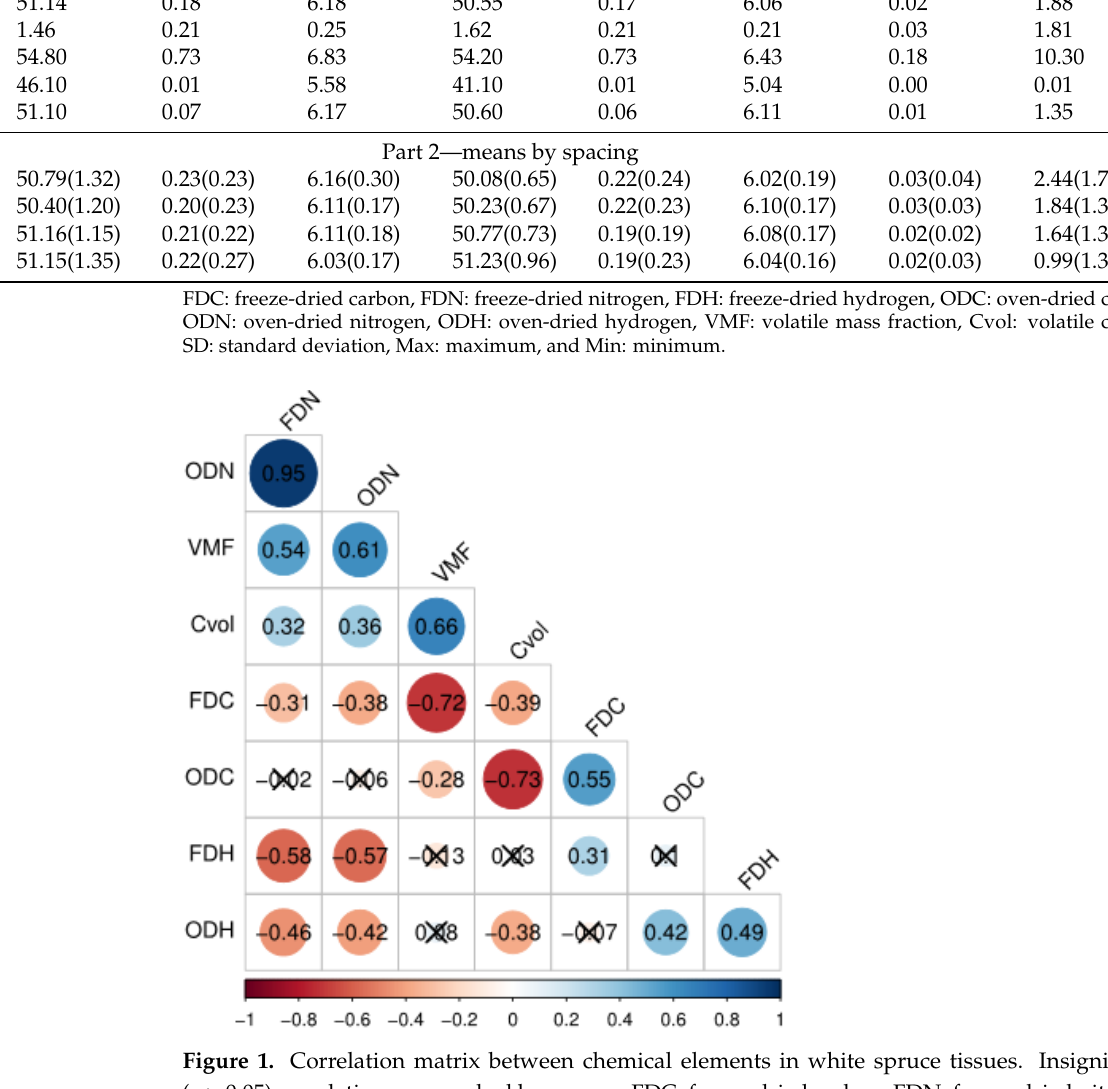
Figure 1. Correlation matrix between chemical elements in white spruce tissues. Insignificant ( p > 0.05) correlations are marked by crosses. FDC: freeze-dried carbon, FDN: freeze-dried nitrogen, FDH: freeze-dried hydrogen, ODC: oven-dried carbon, ODN: oven-dried nitrogen, ODH: oven-dried hydrogen, VMF: volatile mass fraction, and Cvol: volatile